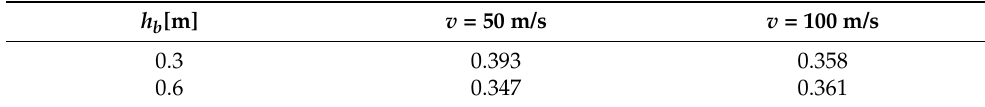
Table 7. Optimum values of c z , based on Table 3.